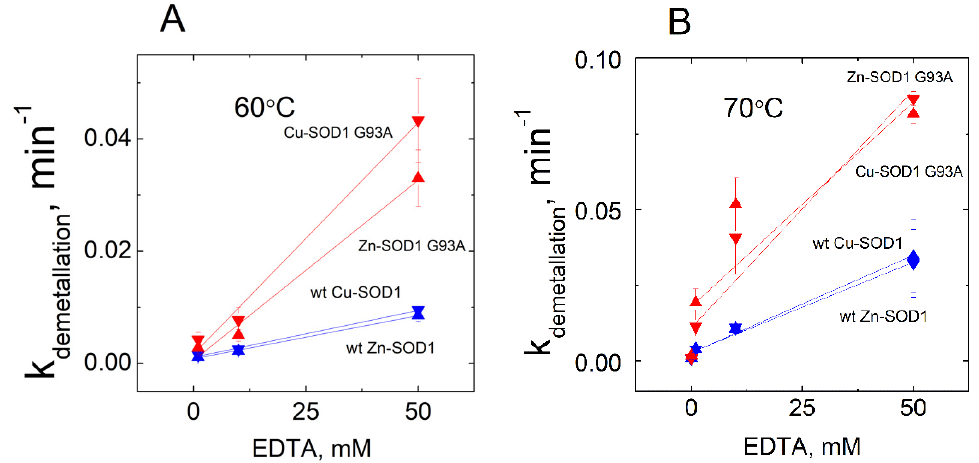
Figure 4. Dependence of the rate constant of demetallation of wt Cu,Zn-SOD1 and its G93A mutant on the EDTA concentration. Demetallation of wt Cu,Zn-SOD1 (blue symbols) and Cu,Zn-SOD1 G93A mutant (red symbols) at 60° C ( A ) and 70° C ( B ). Conditions: 10 µM wt Cu,Zn-SOD1 and 10 µM of its G93A mutant in 50 mM HEPES/50 mM NaCl, pH 7.3.